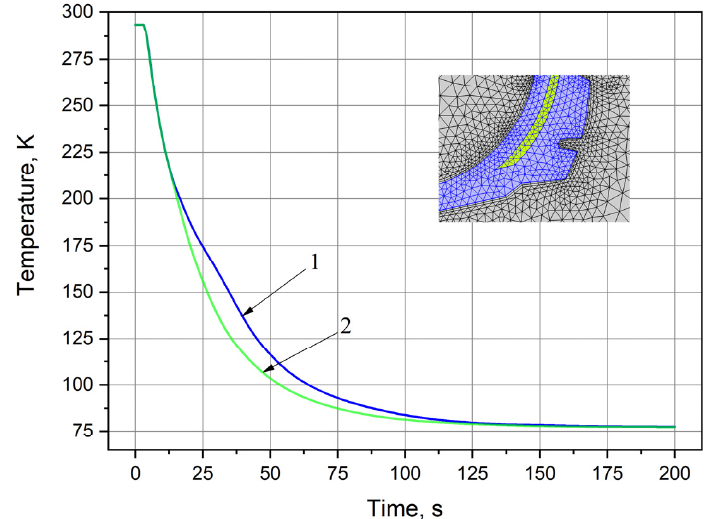
Figure 7. Tire cooling graph. 1—average temperature change in grid nodes for the entire model cross-section; 2—average temperature change in grid nodes for the cross-section of the metal cord.